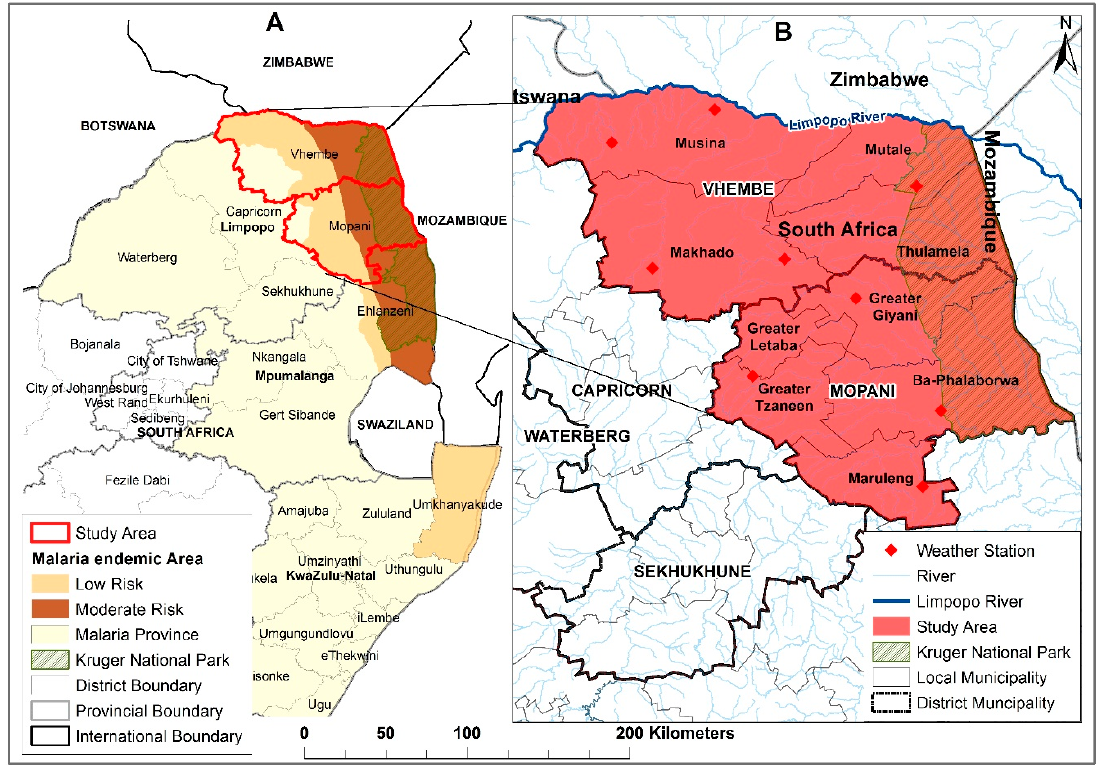
Figure 1. Location of study area, showing ( A ) the malaria risk classification of South Africa and Kruger National Park; ( B ) the location of weather stations, the local municipalities and Mopani and Vhembe district municipalities, Limpopo province, South Africa.